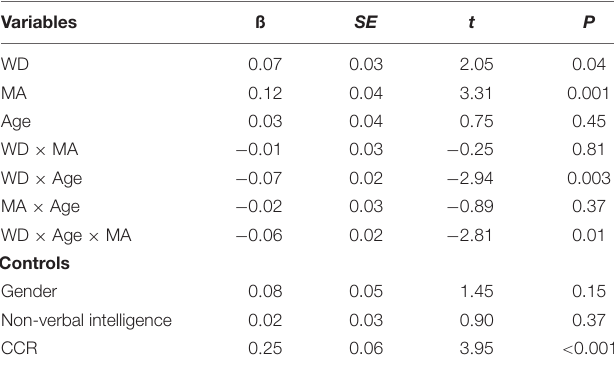
TABLE 2 | Results of the linear mixed model for reading